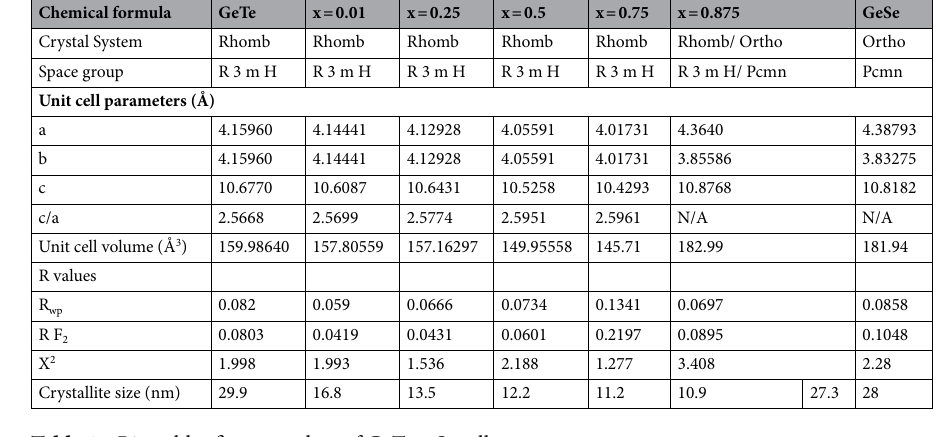
Table 1. Rietveld refinement data of GeTe 1−x Se x alloys.